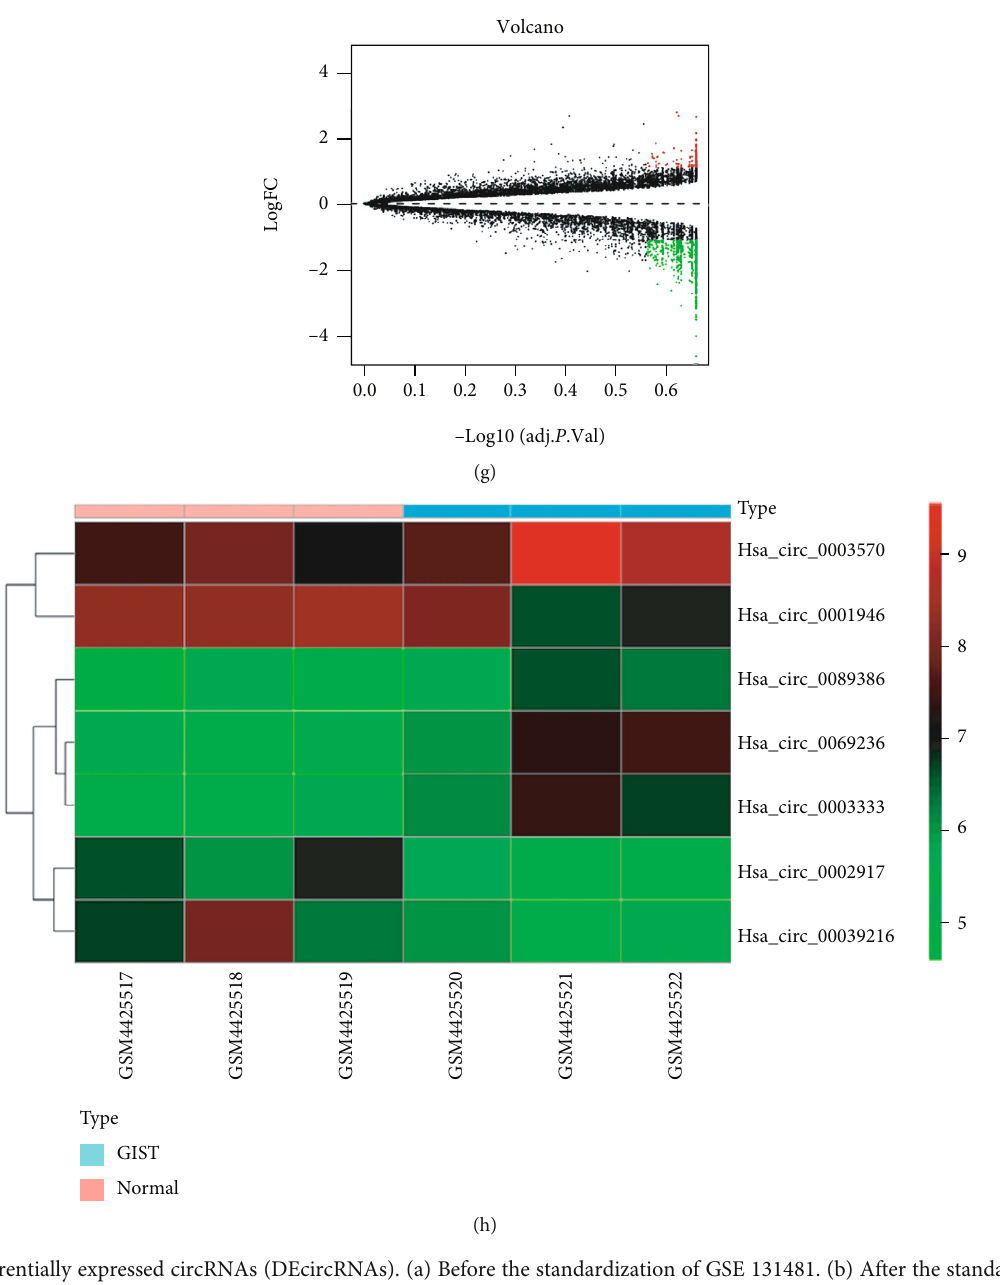
Figure 1: Di ff erentially expressed circRNAs (DEcircRNAs). (a) Before the standardization of GSE 131481. (b) After the standardization of GSE131481. (c) Volcano plot of GSE131481. (d) Heatmap of GSE131481. (e) Before the standardization of GSE147303. (f) After the standardization of GSE147303. (g) Volcano plot of GSE147303. (h) Heatmap of